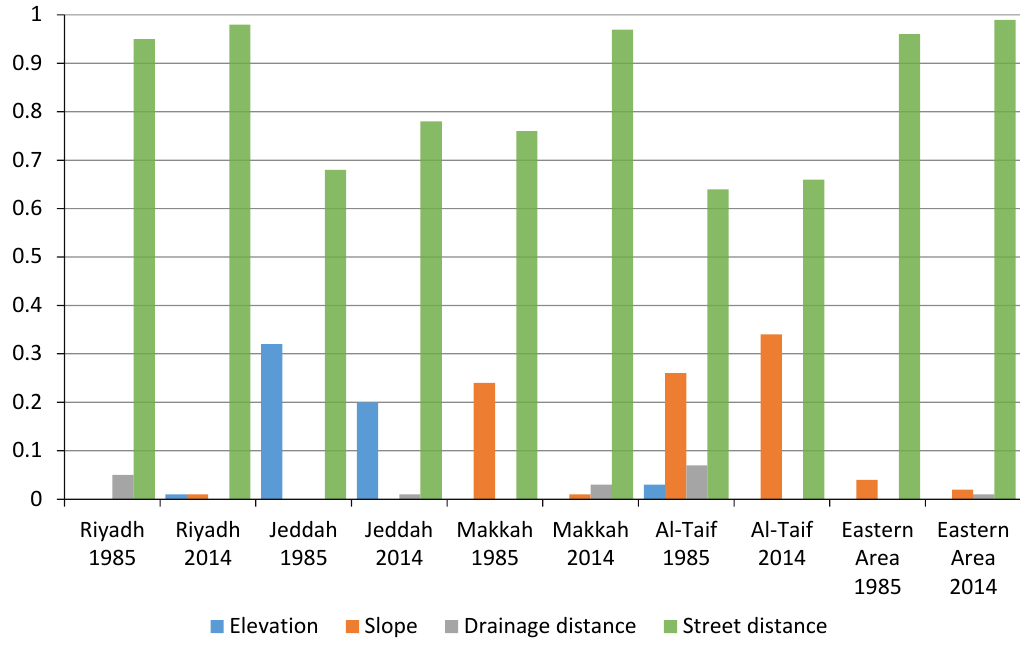
Figure 11. The impact of the various predictors of the driving factors across the five cities